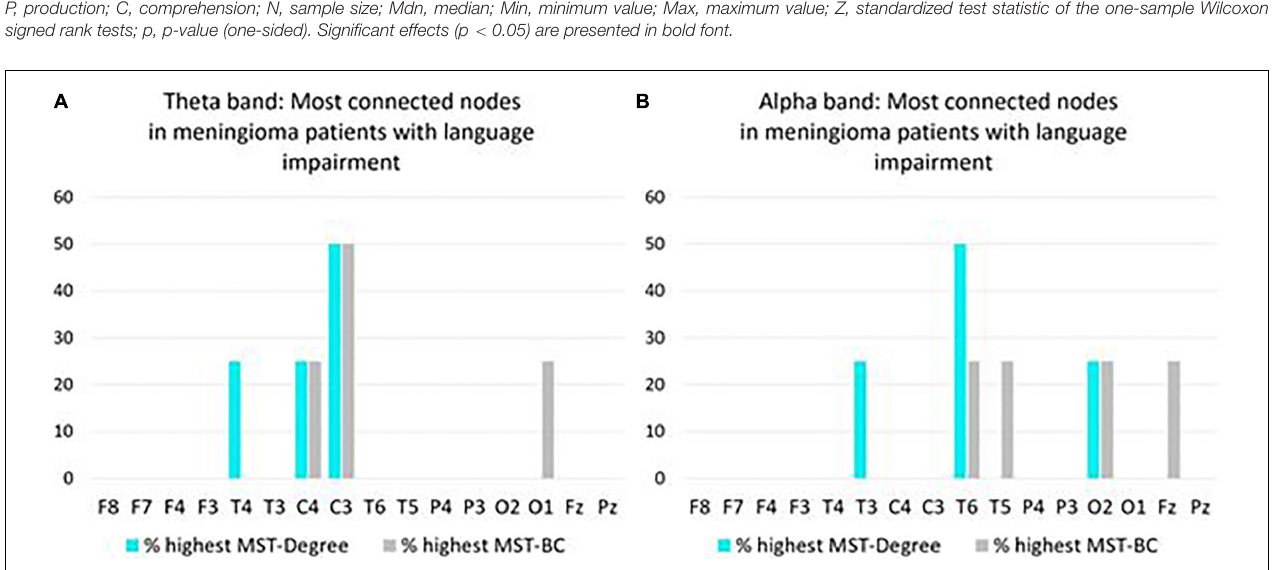
Frontiers in Neuroscience |